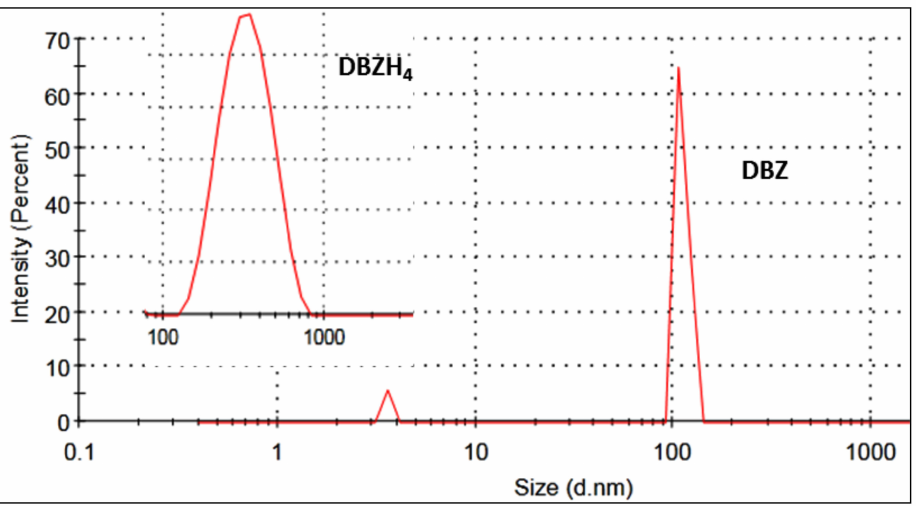
Figure 9. Size distribution diagram of the self-assembled DBZH 4 – BSA and DBZH 4 – BSA (inset) in water at room temperature.